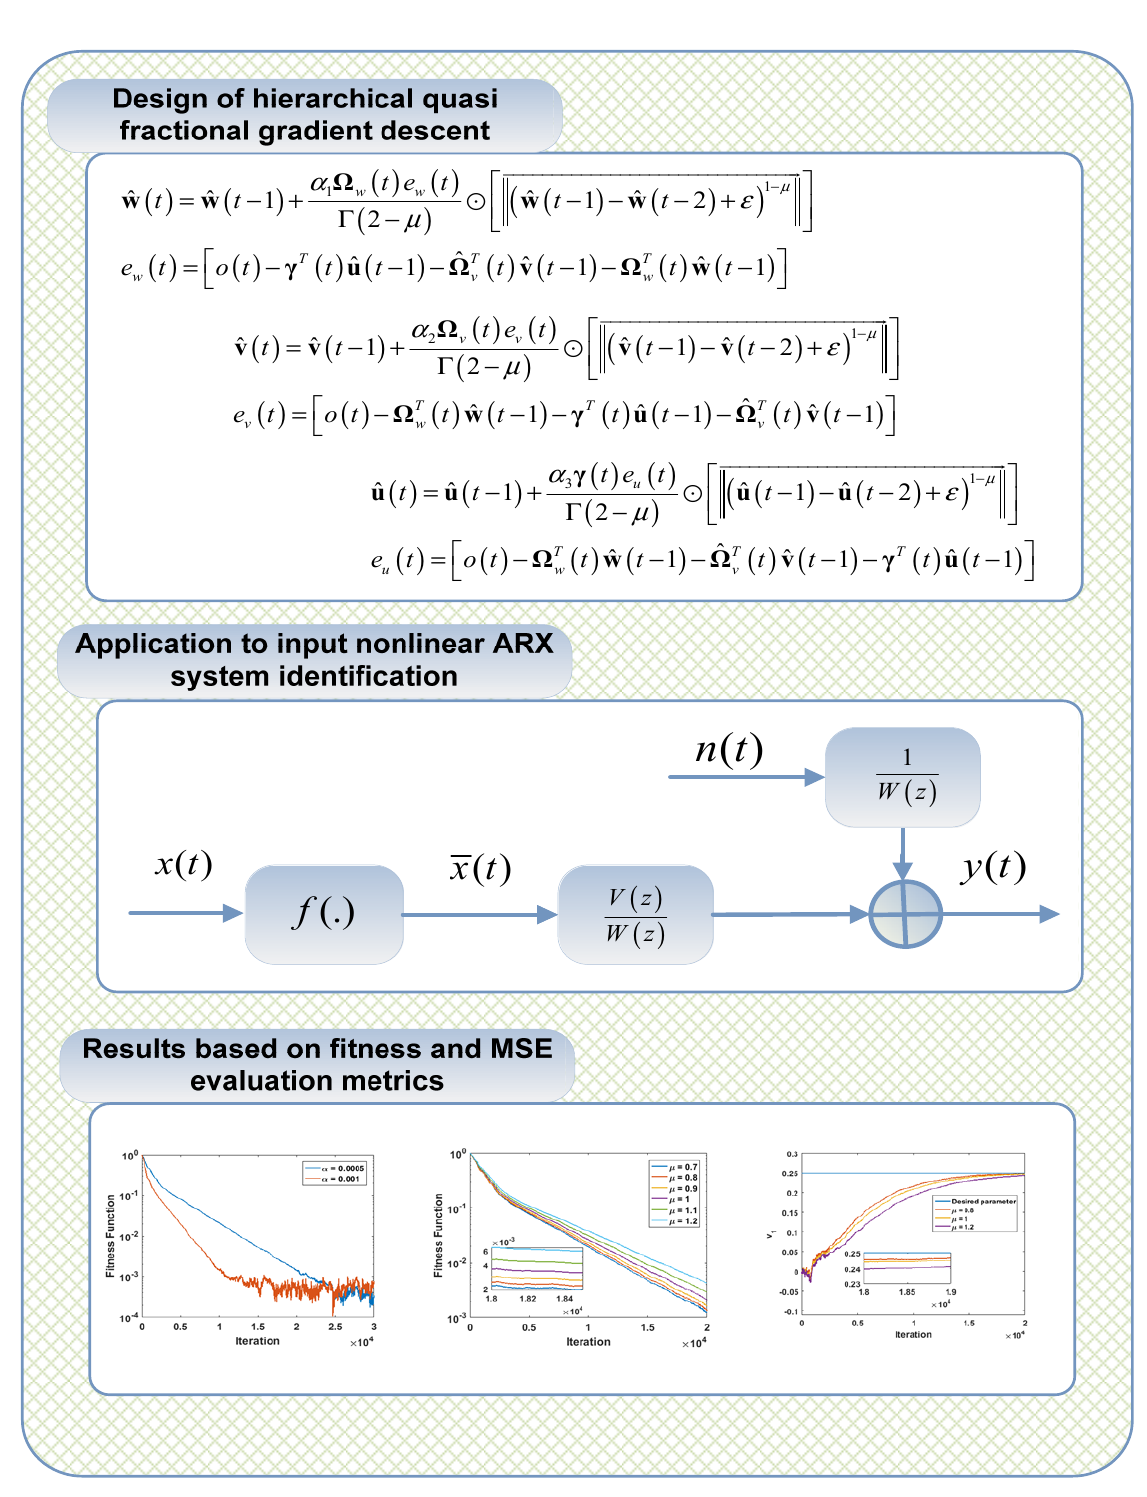
Figure 1. Graphical abstract of the study.